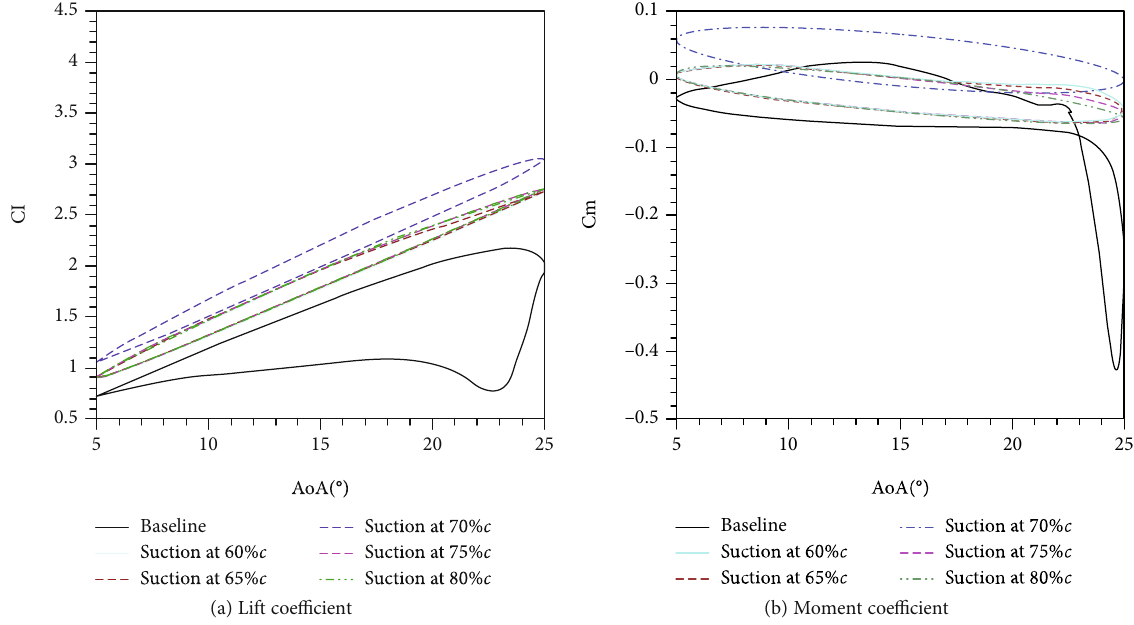
Figure 16: Hysteresis curve of the lift and moment coe ffi cients with AoA at di ff erent suction slot